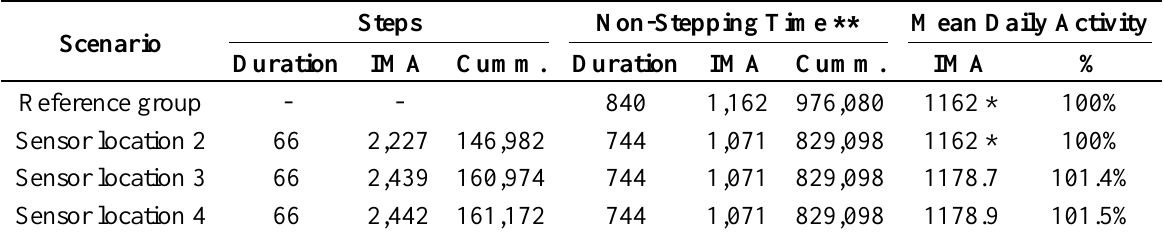
Table 6. Effect of position on mean daily activity in IMA [10 −3 m/s 2 ]. Duration is given in minutes per day. Cumm. = cumulative IMA value for the given duration per